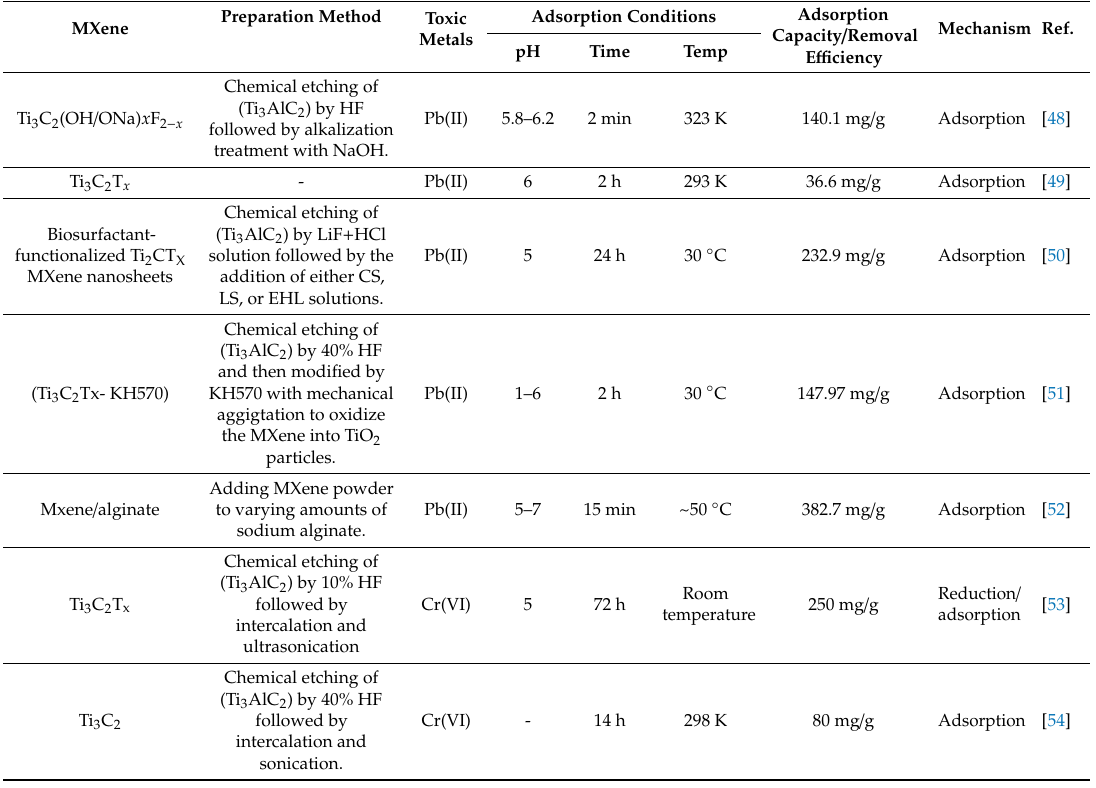
Table 1. Some examples of MXene-based nanostructures for heavy metal removal reported